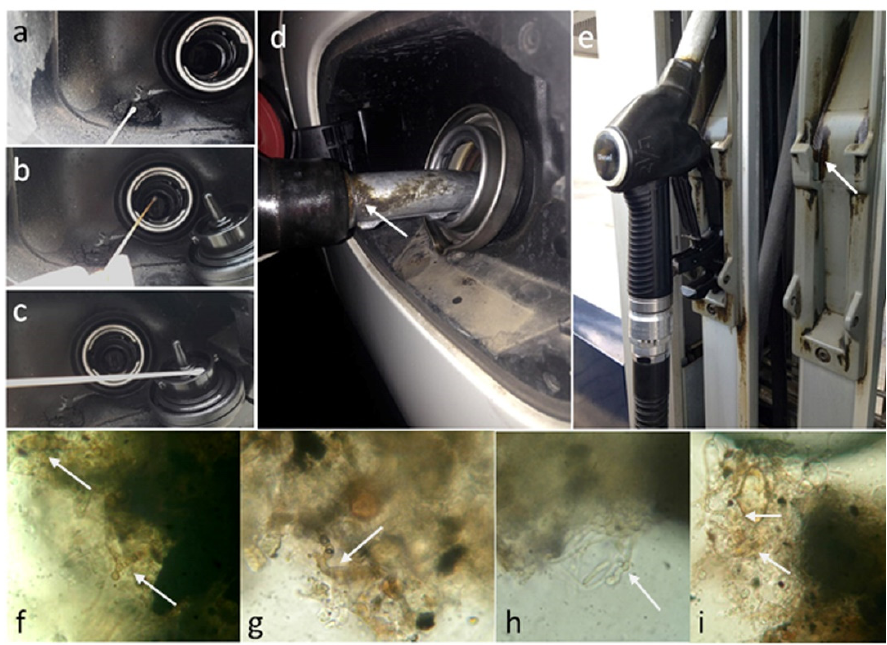
Figure 1. Sampled surfaces: ( a – c ) diesel car tanks; ( d , e ) fuel pumps dispenser. ( f – i ) Magnification of biofilms taken from dripping fuels; white arrows indicate thick dark hyphae.